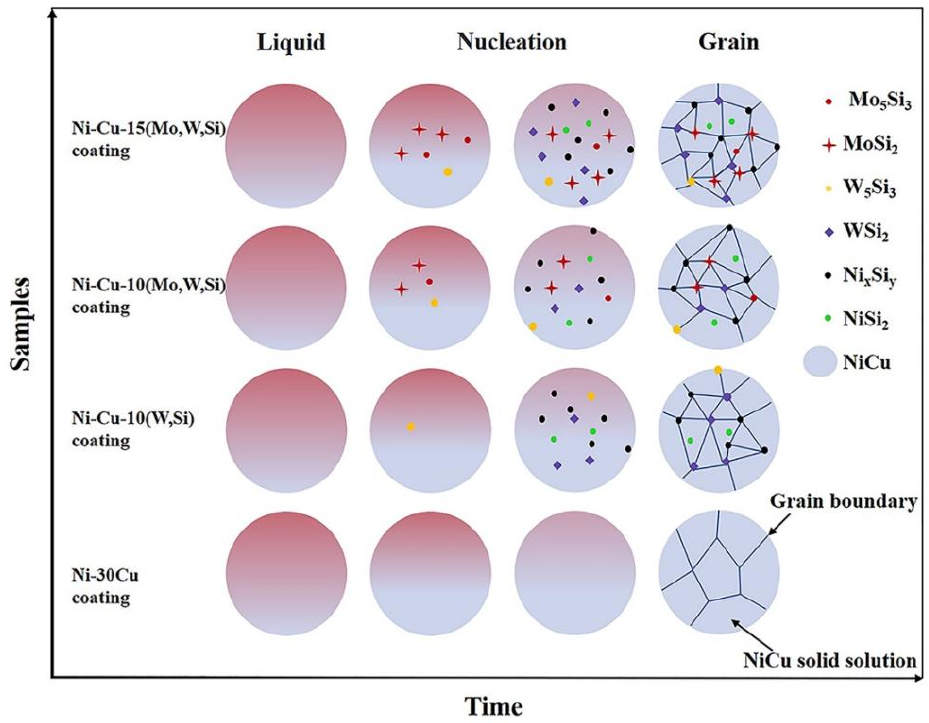
Figure 7. Simplified diagram of the organization of four coatings.